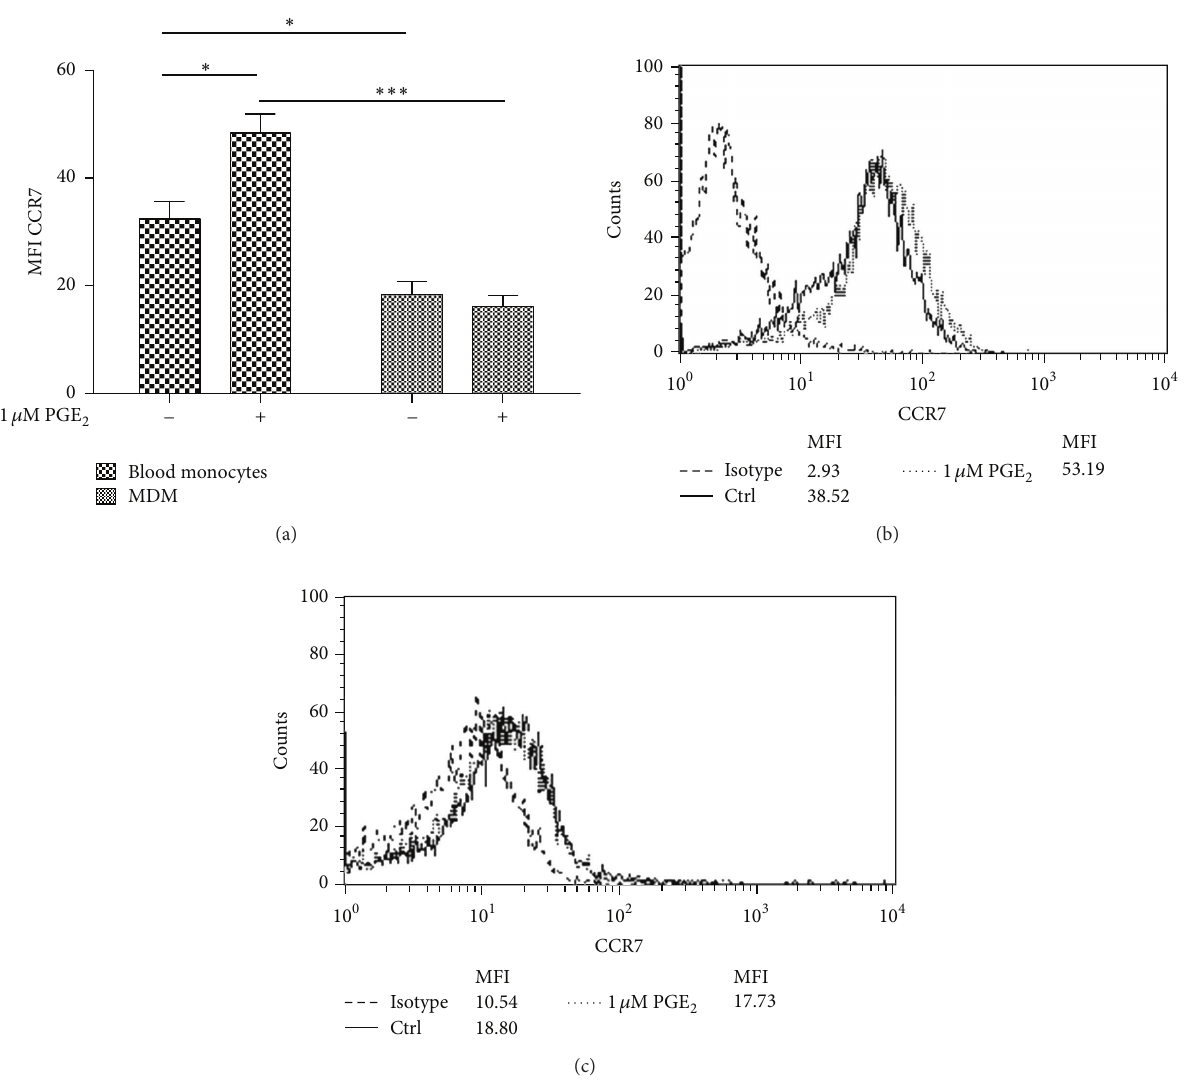
Figure 6: PGE 2 has no effect on MDMs CCR7 expression. (a) CCR7 surface expression on blood monocytes and MDMs was evaluated by flow cytometry following treatment with 1 𝜇 M PGE 2 for 24 h. Data represent the means of five different healthy donors. Histograms from one of five experiments for (b) blood monocytes and (c) MDMs are presented. ∗ 𝑃 < 0.5 , ∗∗∗ 𝑃 < 0.001